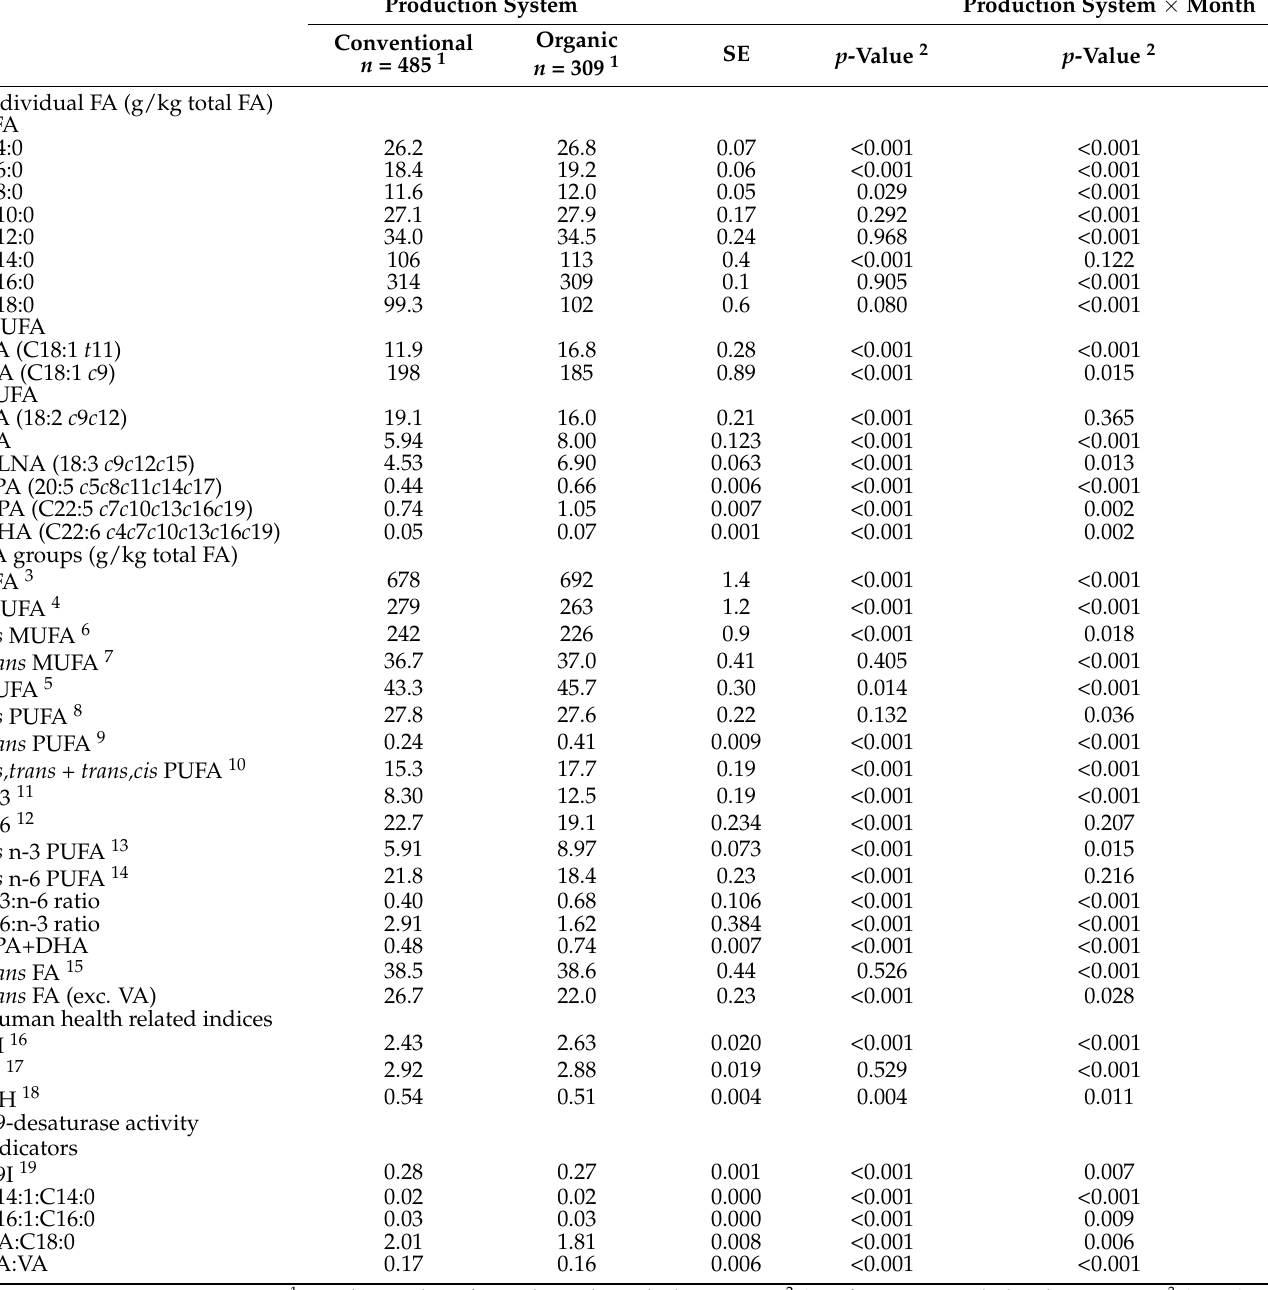
Table 3. Means ± SE and p -values for the effect of production system on the milk fatty acid profile from 67 farms across Southern England with differing production systems (41 conventional and 26 organic